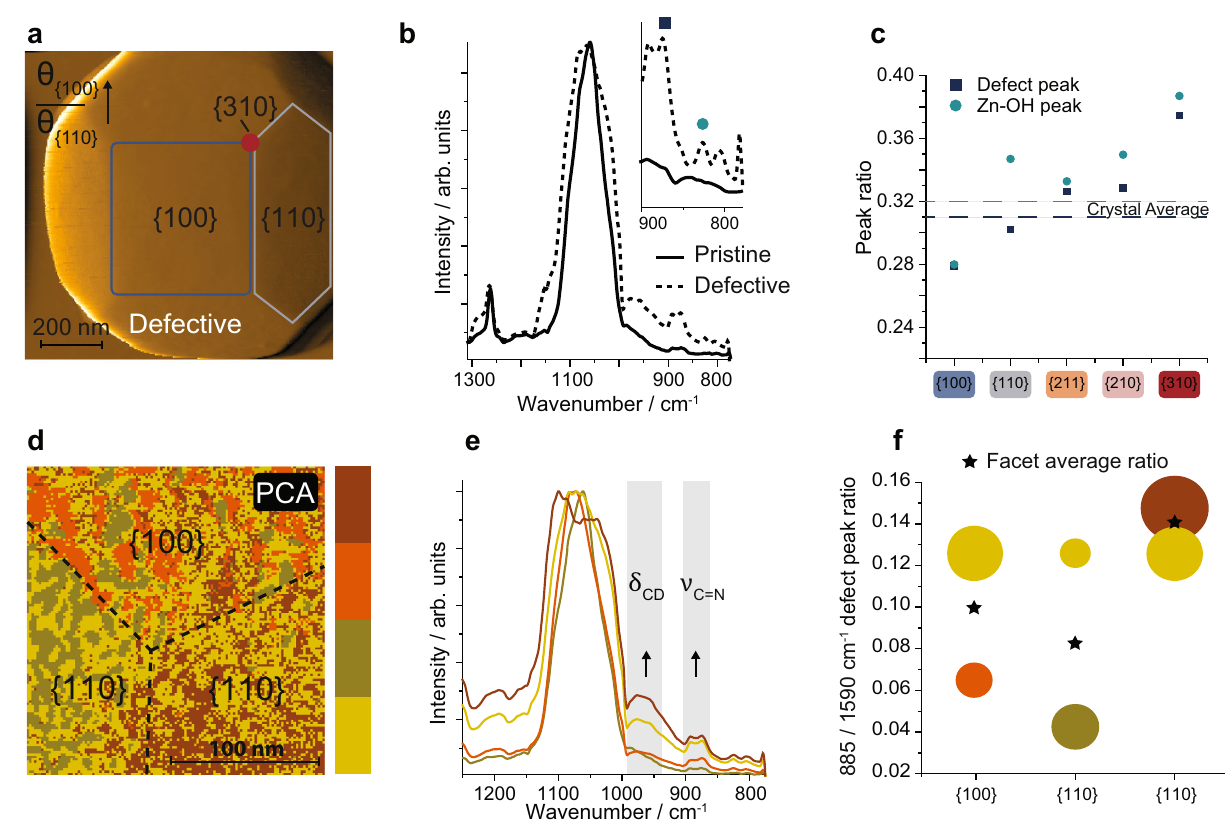
Fig. 4 | Nanoscale visualization ofheterogeneity within crystal planes ofZIF-8. a Representative AFM image of pyrrole-d 5 defect-engineered SURZIF-8, showing a higher ratio of {100}/{110} facets compared to the pristine crystals (Fig. 2). b Spec- troscopic evidence for defect linker incorporation wasfound when comparing the crystal-averaged spectra of a pristine (solid trace) and a defective (dashed trace) crystal. The defective ZIF-8 spectrum showed δ CD and ν C=N vibrations at 960 and 885cm − 1 correspondingtothedefectlinker,and δ OH vibrationsat840and790cm − 1 corresponding to defect-induced Zn-OH sites, see inset. c Using peak ratios of the defective linker(885/1590cm − 1 )and Zn-OH(790/1590cm − 1 )sites, weshowthatthe concentrations of such sites are larger for high-energy planes. Crystal-averaged peak ratios are given by solid lines. d A clustered 200×200nm 2 hyperspectral image made through principle component analysis (PCA) and clustering where